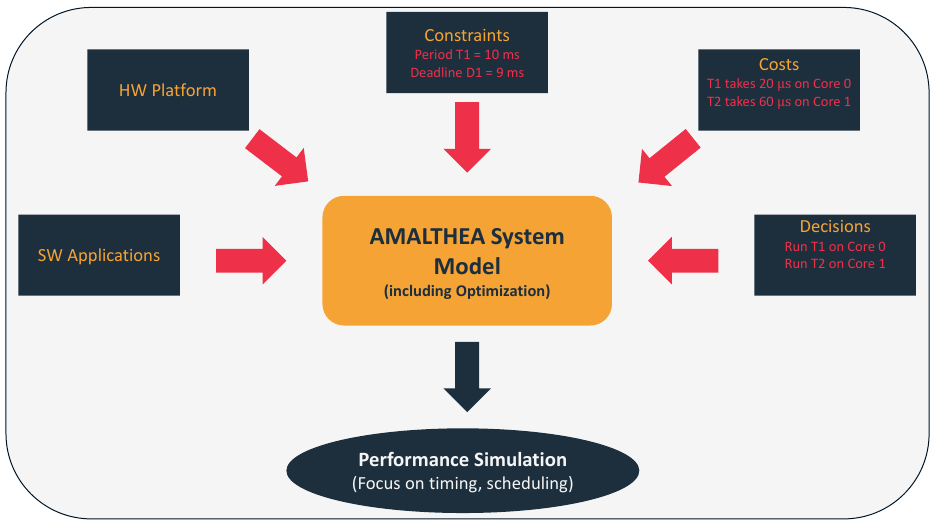
Figure 6. The APP4MC